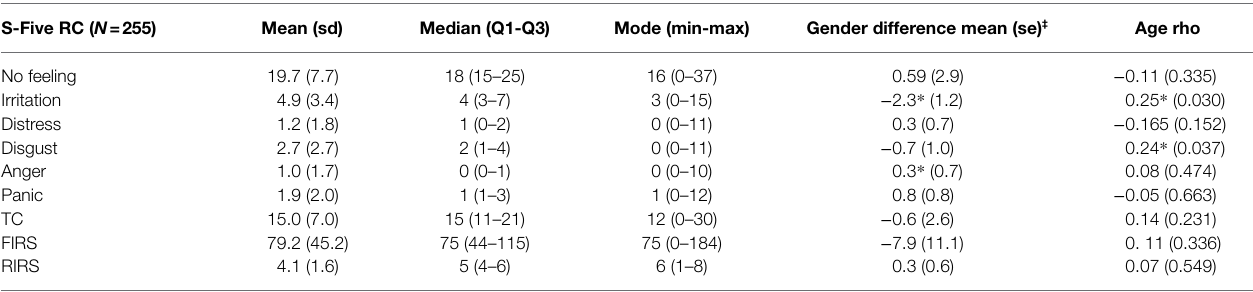
TABLE 4 | Norms and reliability of the S-Five-T scores ( N =